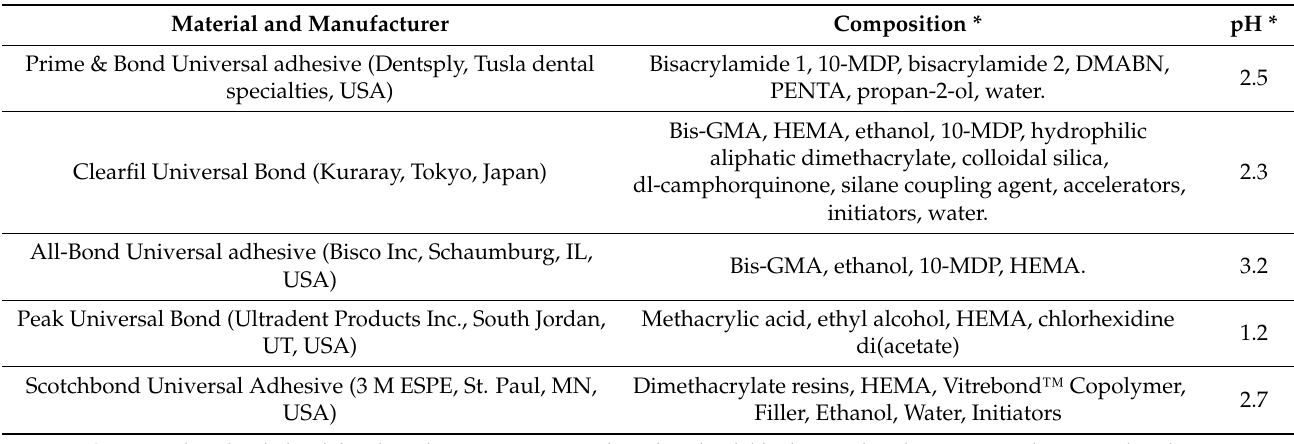
Table 3. Chemical composition of universal adhesives included in the systematic